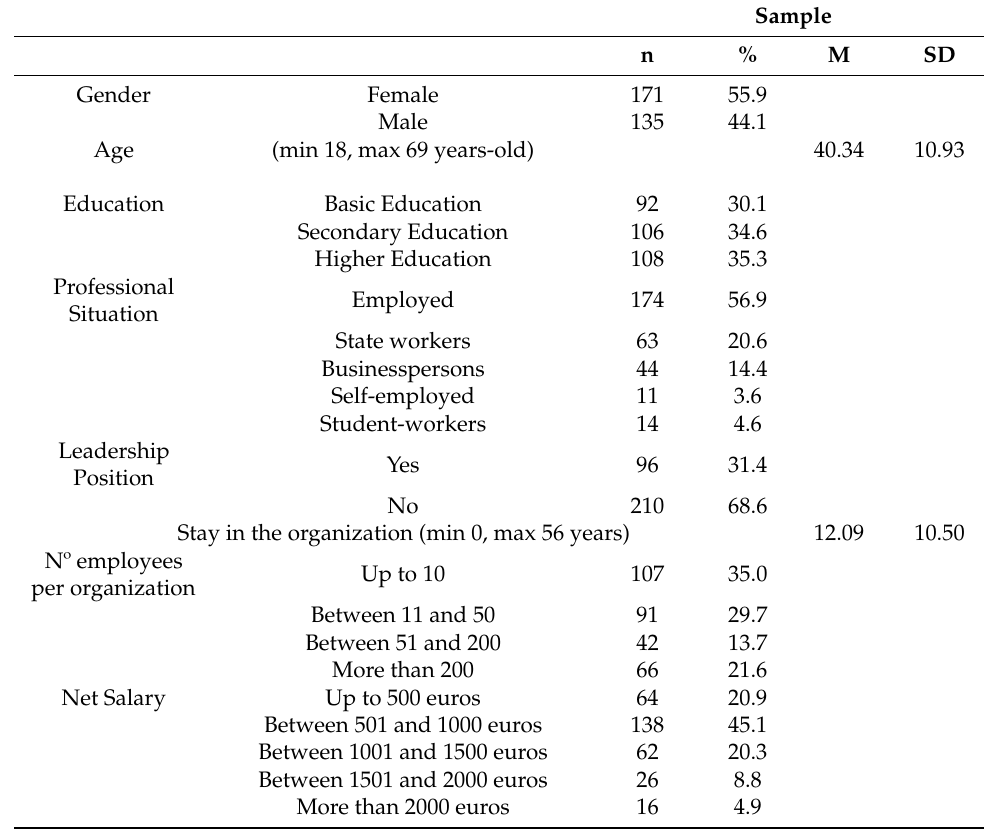
Table 1. Sociodemographic characterization of the sample [ N =